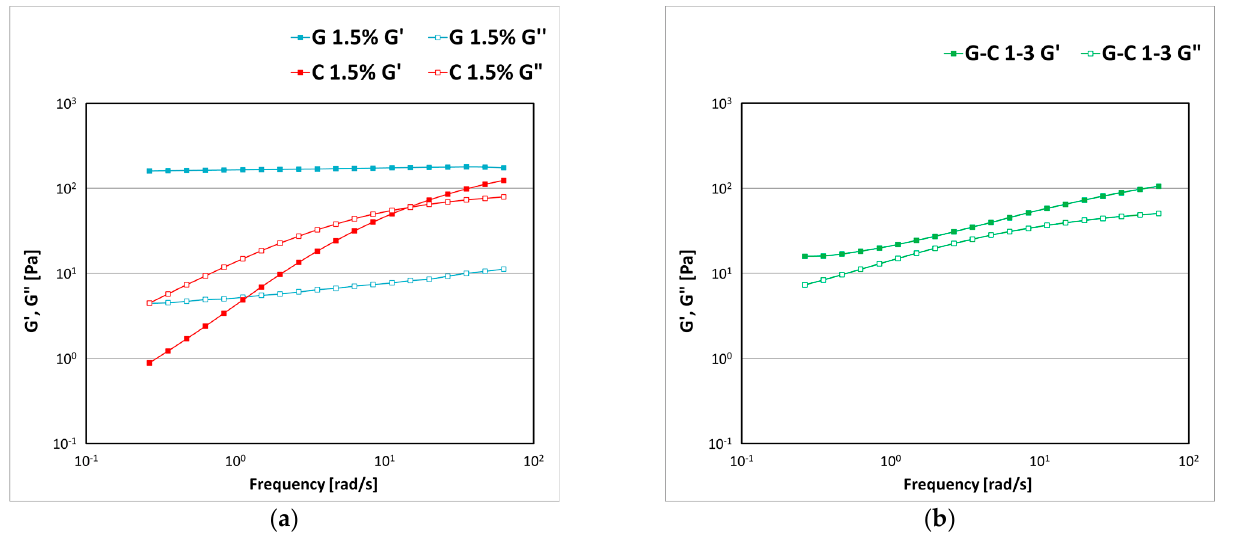
Figure 2. Storage (G ′ ) and loss (G ″ ) moduli trends as a function of the frequency for the samples prepared with G and C ( a ) and the G–C association (1:3) ( b ) at the same total polymer amount (1.5% w/w).